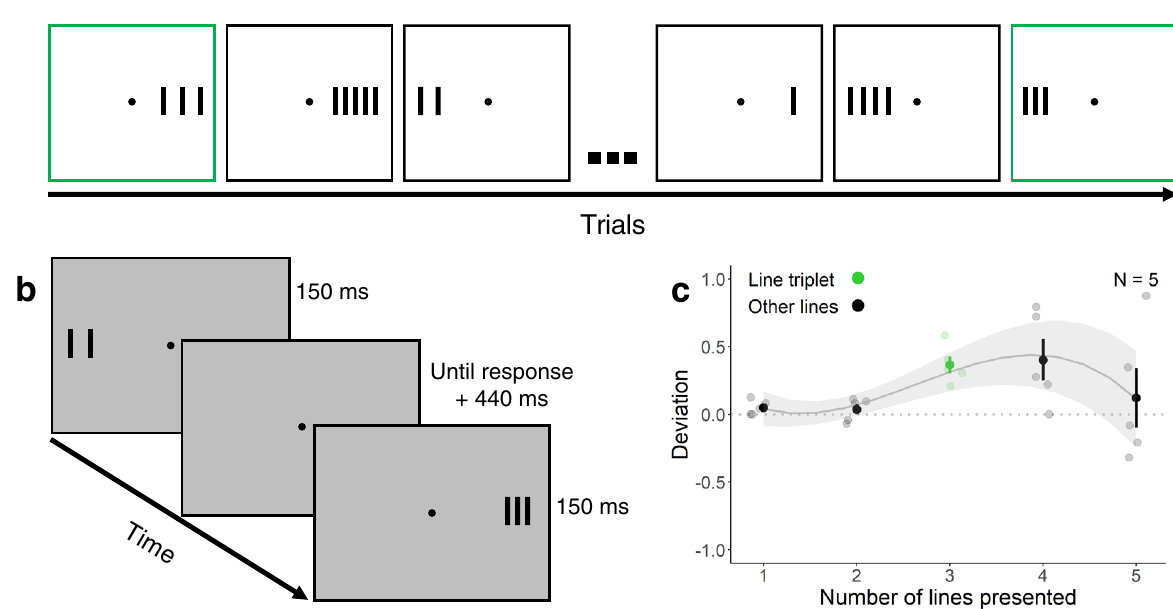
Figure 2. Illustration of a sequence of trials ( a ), schematic depiction of the experimental paradigm ( b ), and results of Experiment 2 ( c ). ( a ) The line triplet is shown with green frames (for illustration). ( b ) Observers were randomly presented with 1 to 5 lines with different spacings to the left or right side of fixation. ( c ) Deviation scores are plotted as a function of the number of lines presented. Black and green data points show mean deviation scores (± SEM ). Grey and light green data points show mean deviation scores for each individual observer. The grey line and shaded regions show the model fit and confidence intervals (± 1.96 * SEM